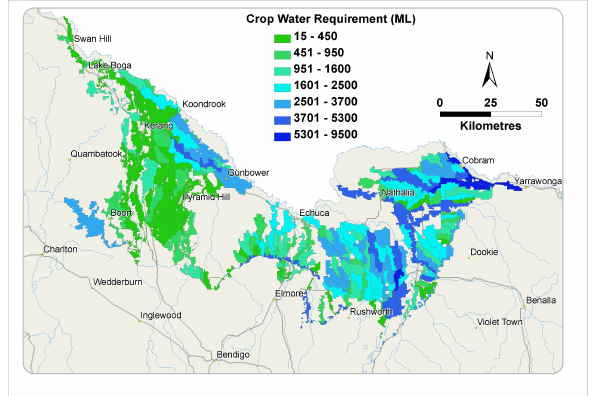
Figure 1. Crop water requirement (CWR) during January – April 2009 in Goulburn-Murray catchment.